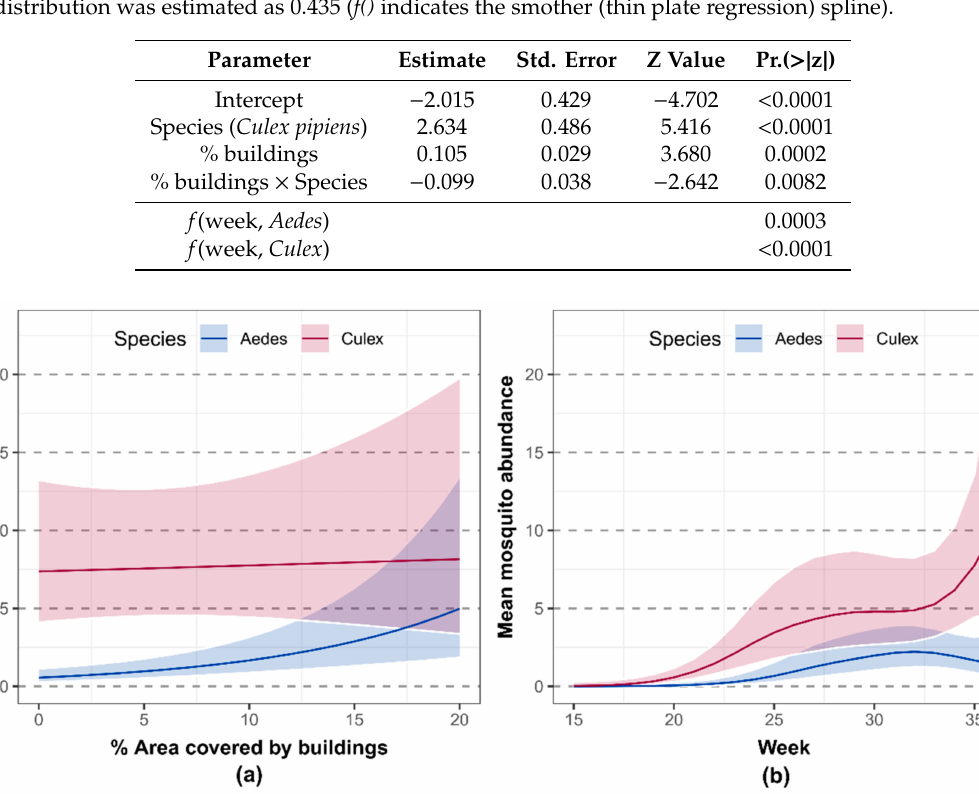
Table 1. Results of the generalized additive model. The dispersion parameter of the Negative Binomial